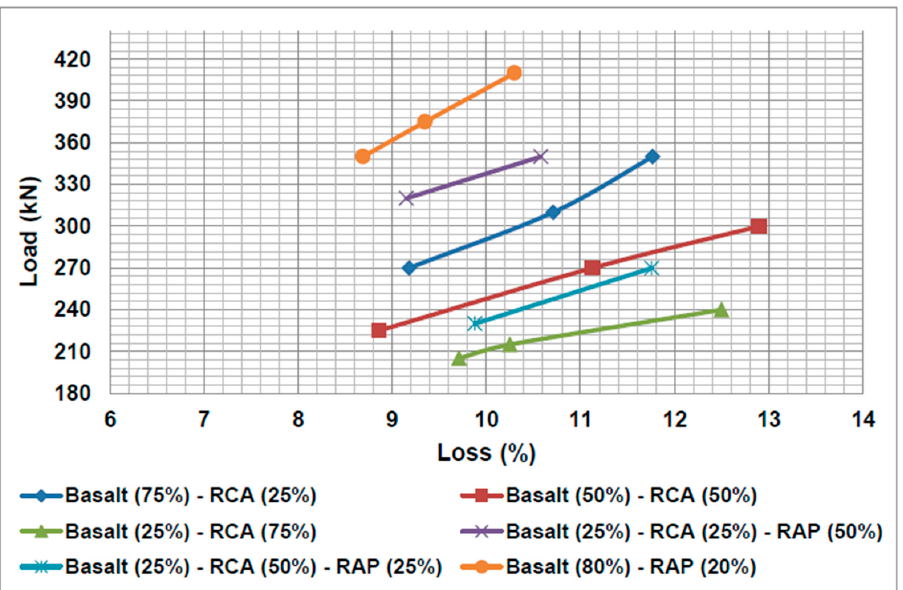
Figure 11. Results of Wet/Dry Strength Test for Mix of Coarse Aggregates (Dry Strength).